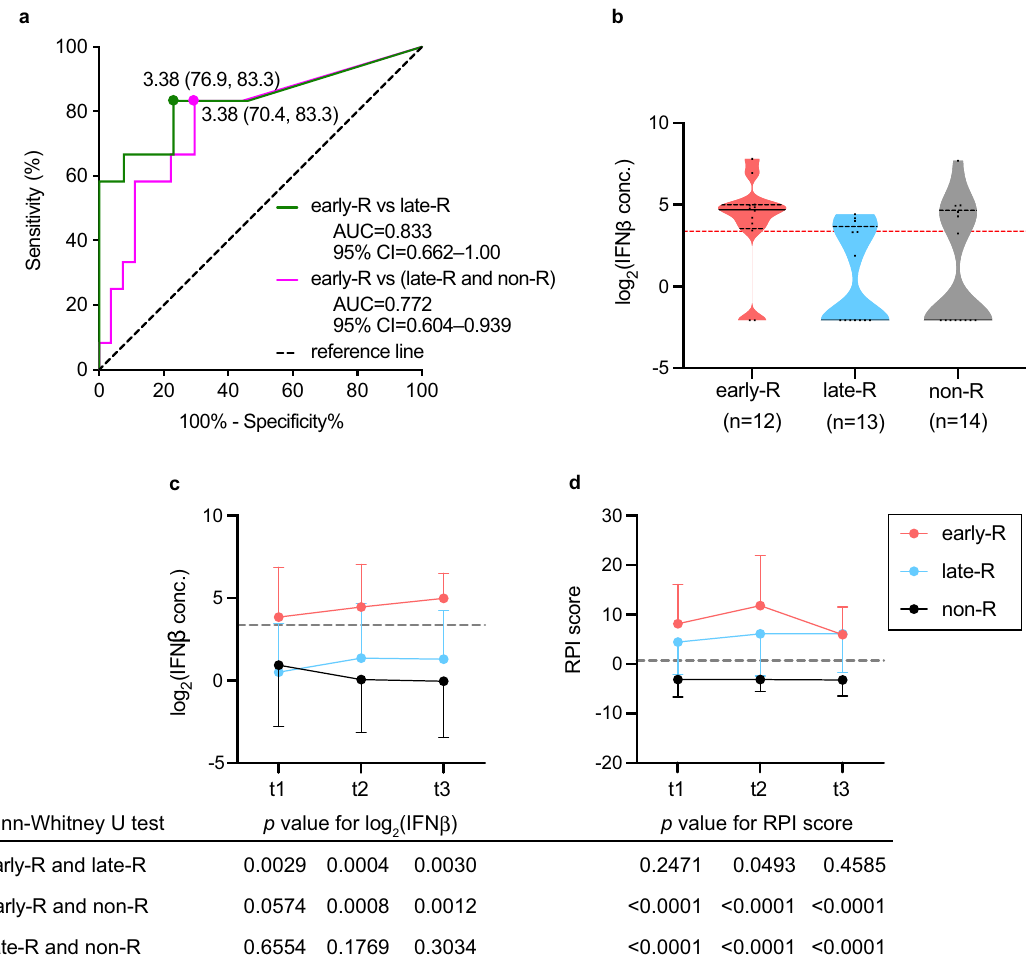
Figure 3. ROC curve and violin plot of IFNβ. ( a ) ROC curves for cut-off derivation against IFNβ. ROC in the green line is based upon early versus late relapse groups, and that in magenta is based upon early relapse versus late plus non-relapse groups. The area under the curve (AUC) for each of the ROC curves is annotated with the 95% confidence interval (CI) by the Wilson/Brown method. The best threshold measured using the “farthest to diagonal line” method with sensitivity and specificity is also shown as a dot on the ROC curve and as an orange– red dotted line in the violin plot. ( b ) Violin plot showing the distribution of the log 2 transformed level of IFNβ in early (early-R, orange–red), late (late-R, cyan) and non-relapse (non-R, grey) samples. The serum concentration of the analyte was measured in each patient at t1 (Fig. 1a). ( c ) Time-course of changes in log 2 -transformed IFNβ concentrations. Refer to time points t1, t2 and t3 in Fig. 1a. ( d ) Time-course of changes in RPI score. The table indicates p values in the Mann–Whitney U test at each time point corresponding to Fig. 3c, d. The images were created using GraphPad Prism 9 (www. graph pad.